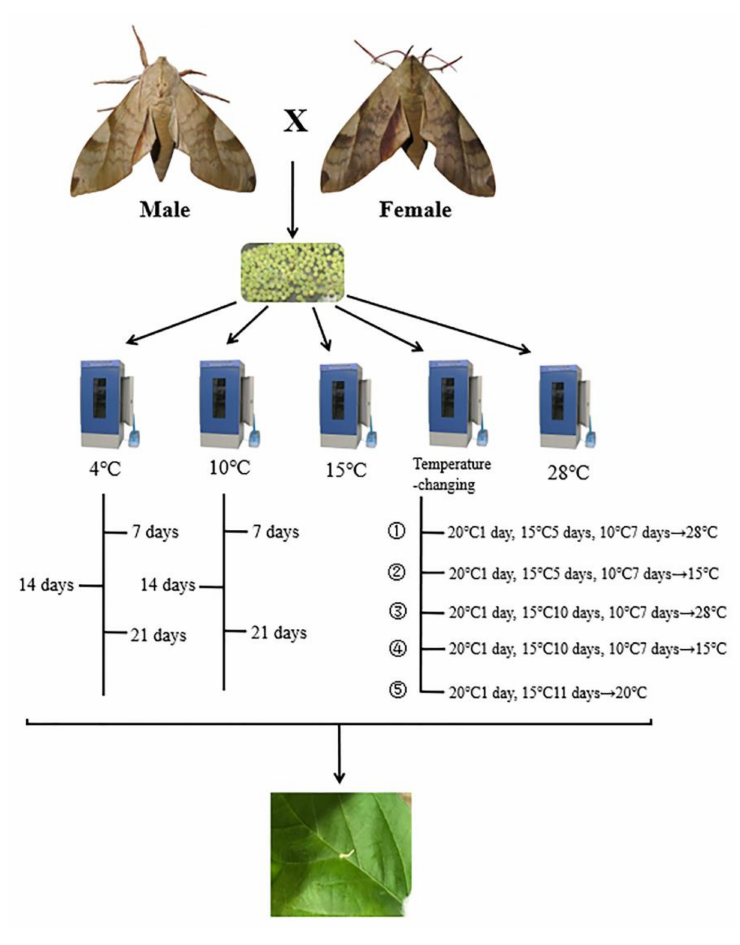
Figure 2. The routine of the whole